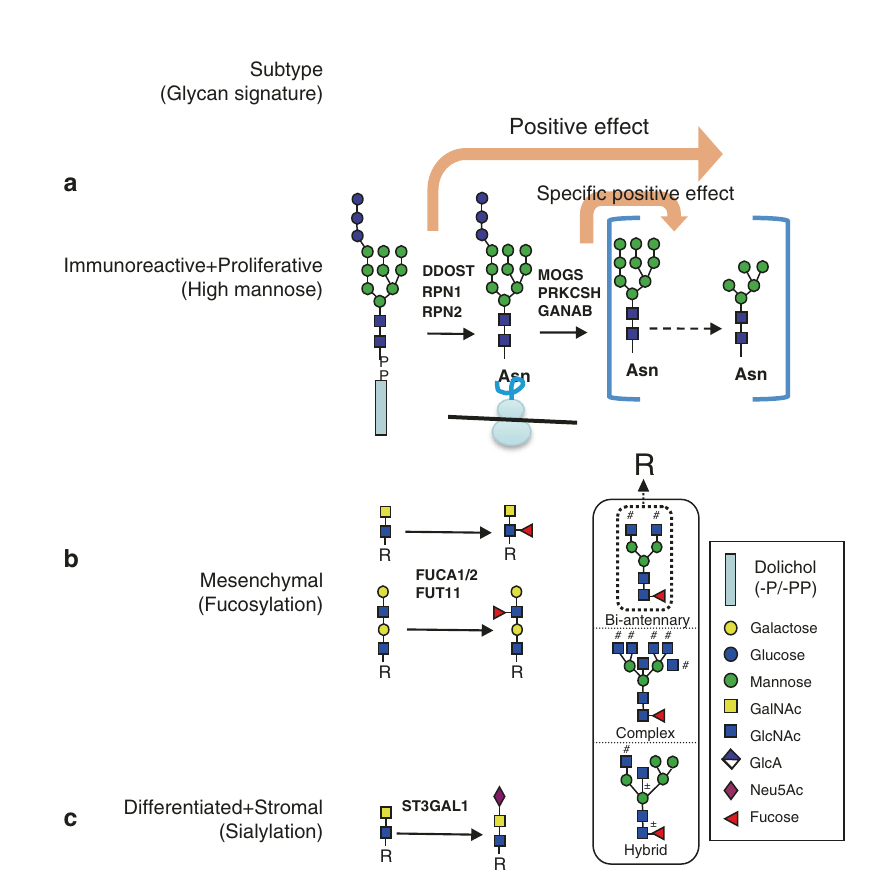
Fig. 7 Glycoprocessing models of different HGSC subtypes. To summarize the molecular feature of ovarian cancer subtypes, we proposed three models involving glycans, glycosylation enzymes, and glycan biosynthesis